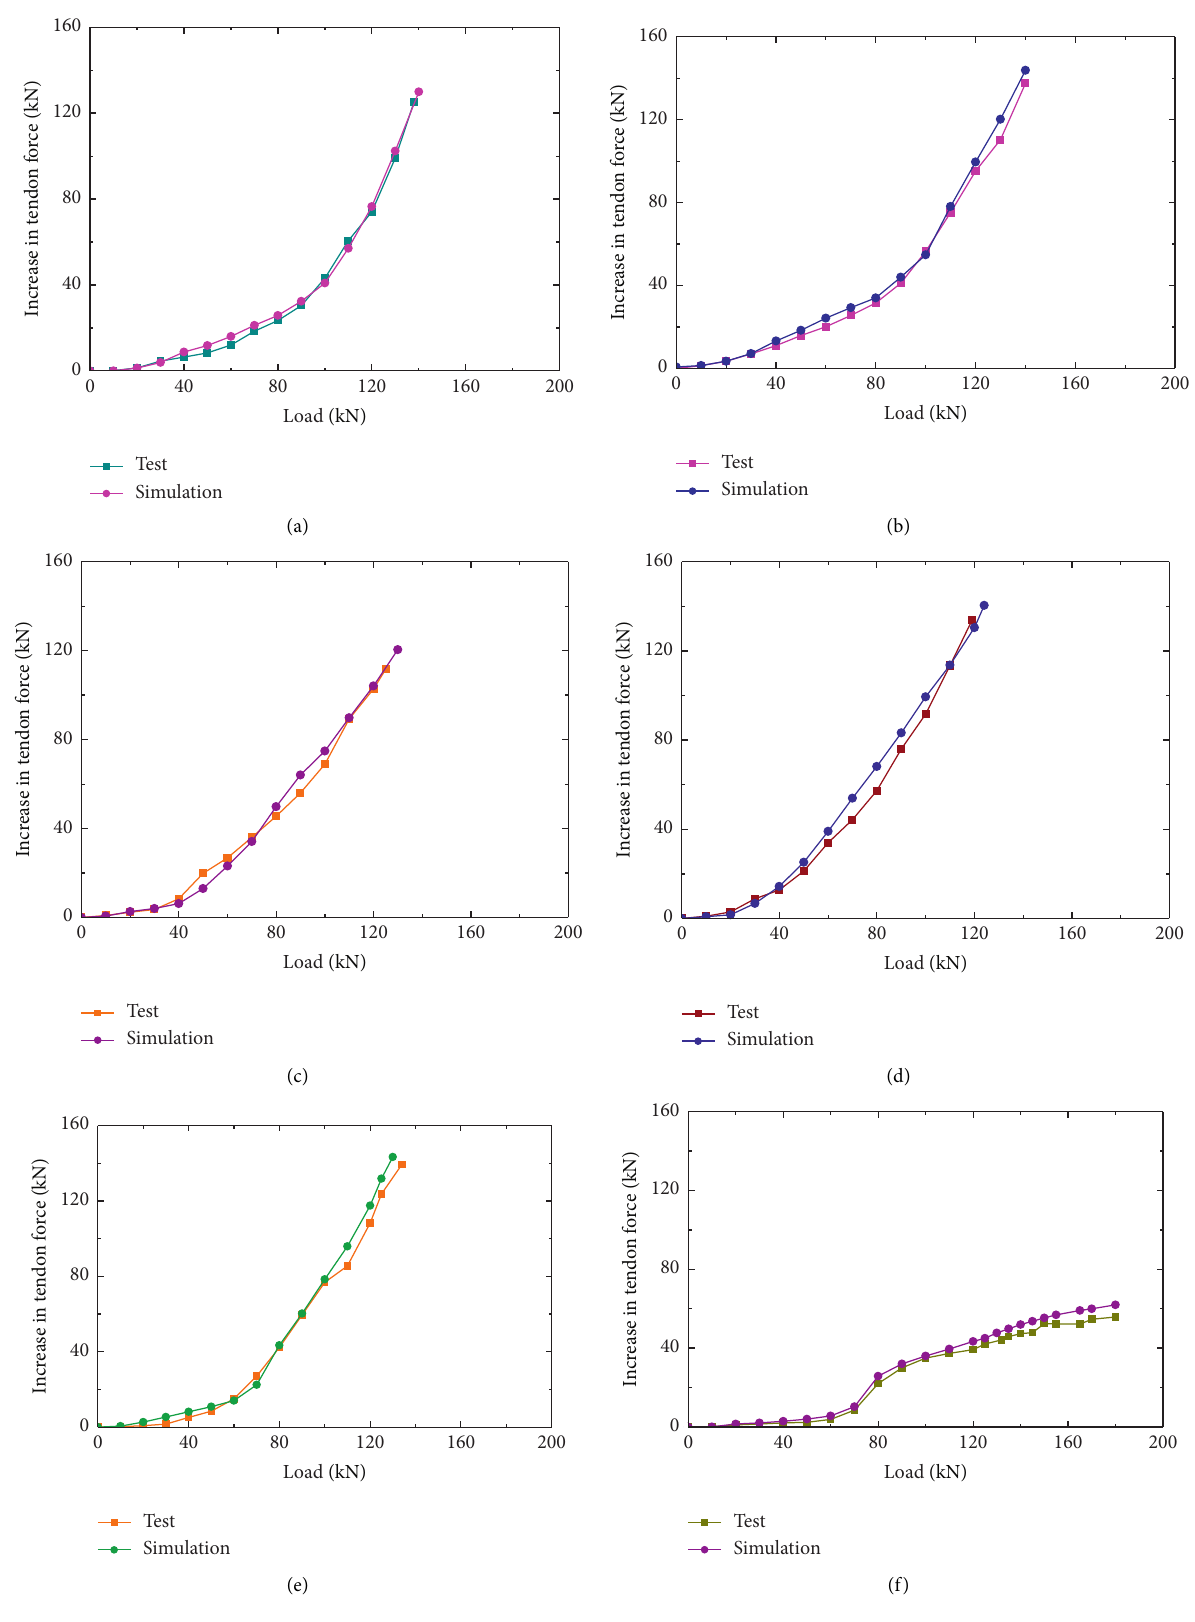
Figure 18: Comparison of test and numerical simulation results: (a) specimen 1, (b) specimen 2, (c) specimen 3, (d) specimen 4, (e) specimen 5, and (f) specimen